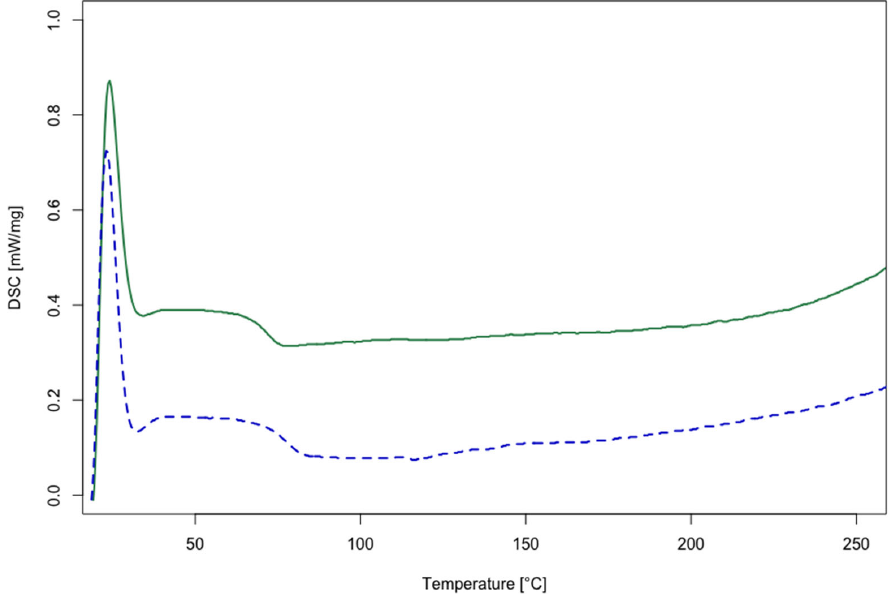
Figure 7. DSC thermograms of the recycled thermoplastics obtained from the chemical recycling process: rTP–I (green curve) and rTP–II (blue curve). process: rTP–I (green curve) and rTP–II (blue curve).